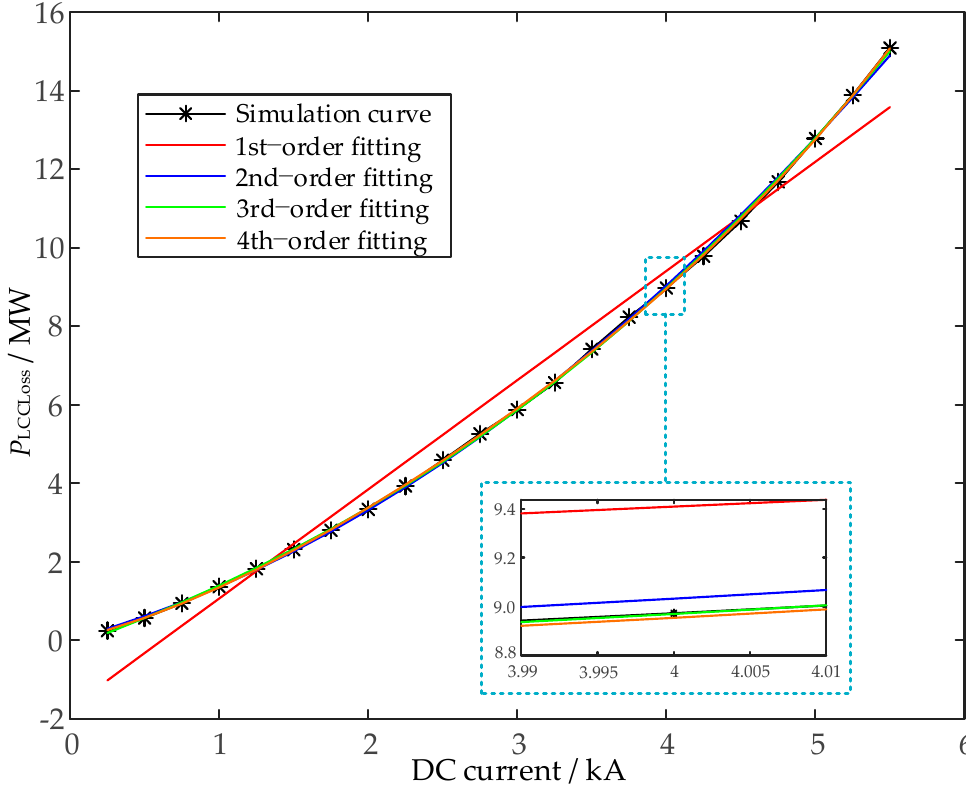
Figure 7. Loss fitting curve of LCC station.